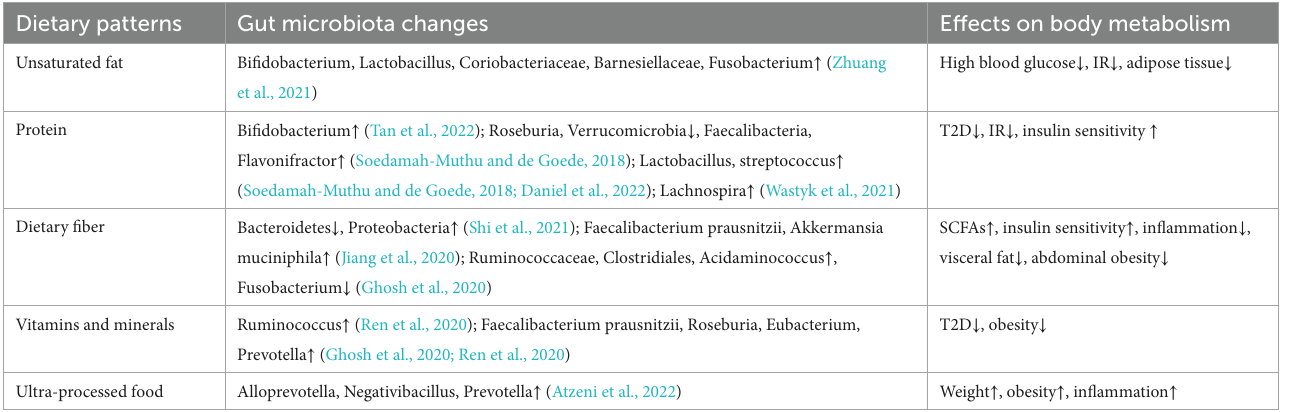
TABLE 3 Effects of dietary patterns on gut microbiota and body metabolism. Dietary